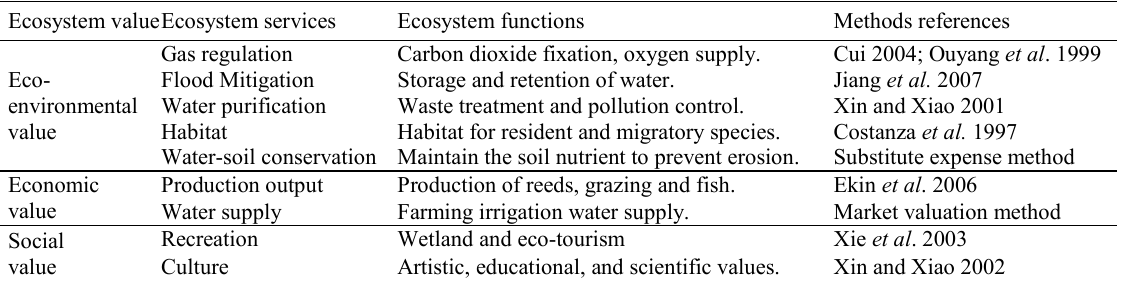
Table 1 Ecosystem services and functions evaluation for the Gudong River wetland. Ecosystem value Ecosystem services Ecosystem functions Carbon dioxide fixation, oxygen supply. Storage and retention of water. Waste treatment and pollution control. Habitat for resident and migratory species.